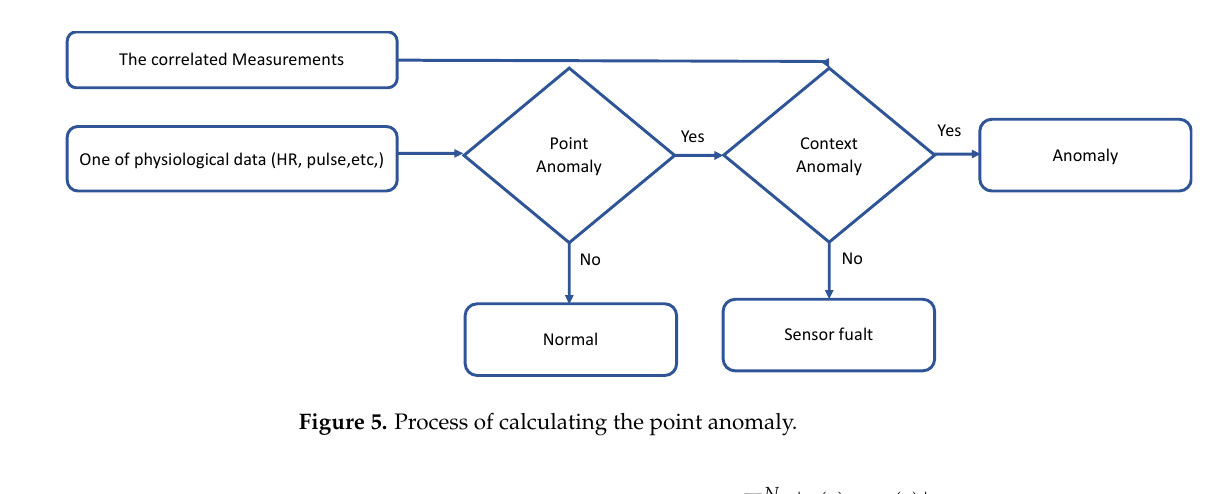
Table 5. Physiological data normal and abnormal ranges [23]